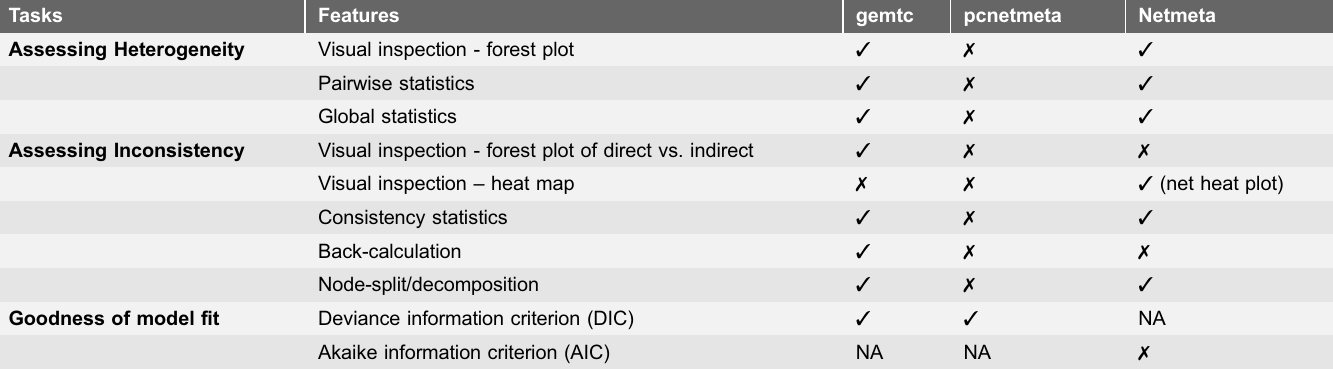
Goodness of model fit